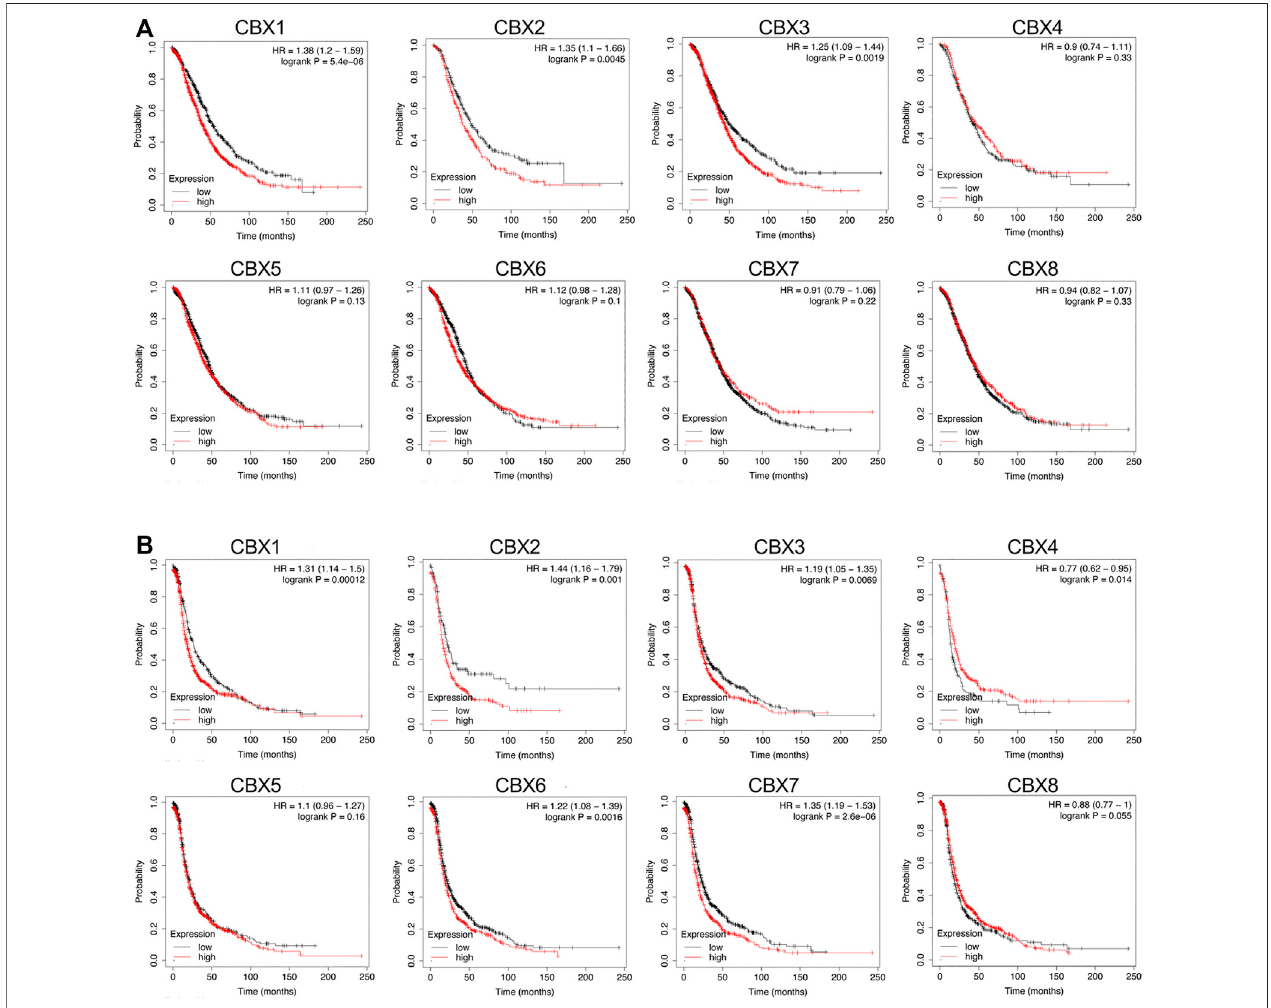
FIGURE4| PrognosticvalueofthemRNAexpressionlevelsoftheCBXsfamilymembersinpatientswithOV(theKaplan-MeierPlotter). (A) Theoverallsurvival(OS) curve of CBX1-8 in patients with OV. (B) The progression-free survival (PFS) curve of CBX1-8 in patients with OV.